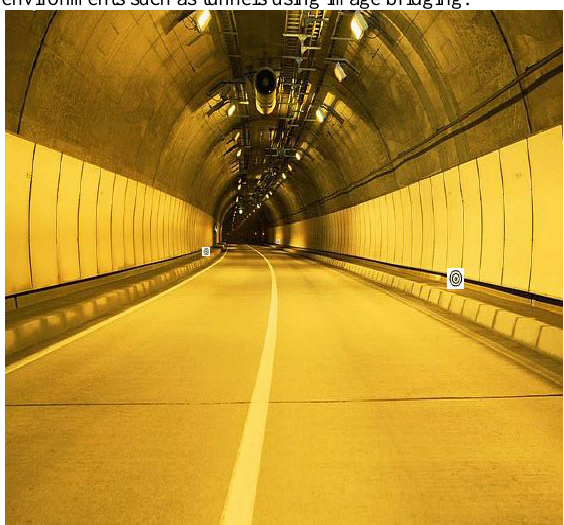
Figure 4 Artificial Targets along Tunnel Corridor